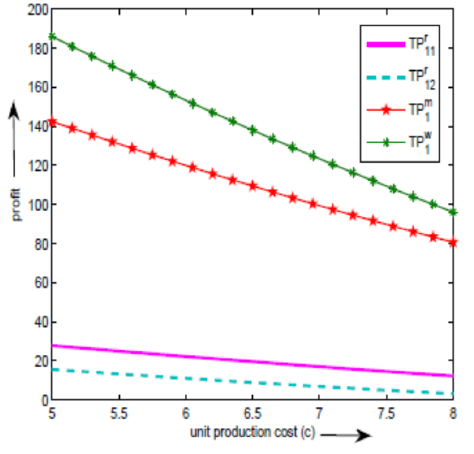
Fig. 8. Unit production cost vs. under pricing strategy 2